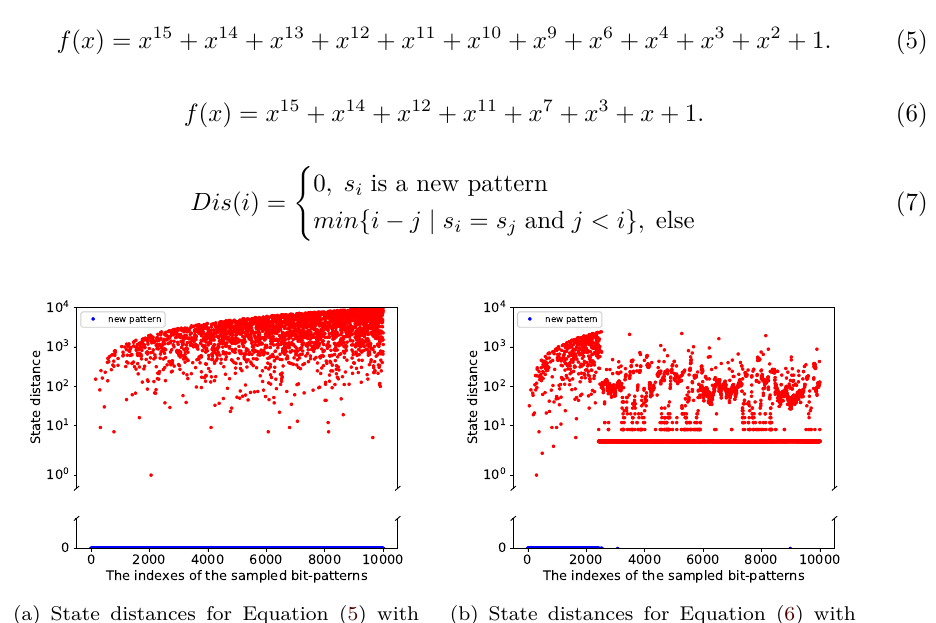
Figure 5: The measured results of full-state